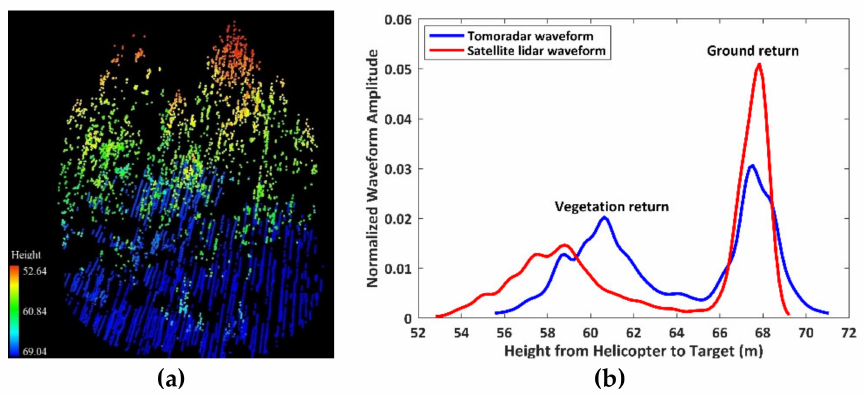
Figure 4. An illustration of Tomoradar waveforms and satellite lidar waveforms from a region with multiple trees. ( a ) A point cloud of vegetation and ground in the selected region; ( b ) Tomoradar waveform (blue line) and satellite lidar waveform (red